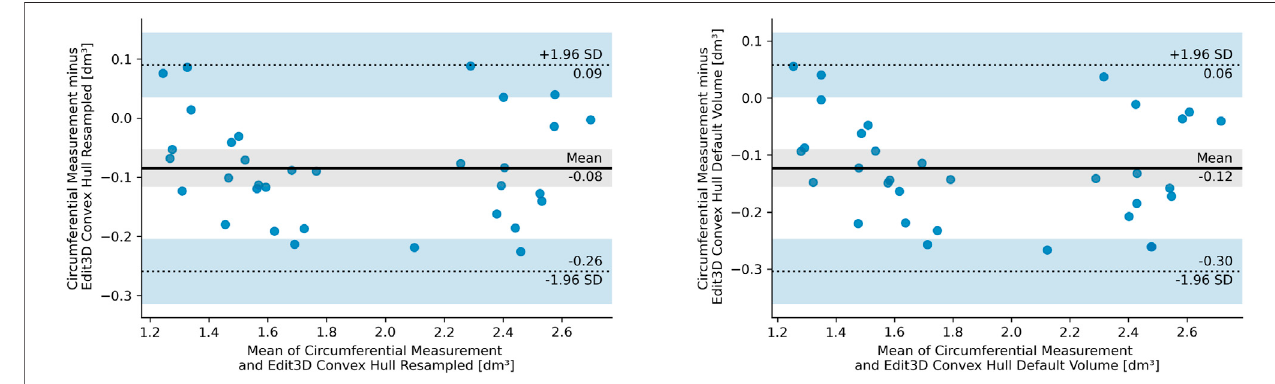
FIGURE5| Bland – AltmanplotofthedifferencesbetweencircumferentialmeasurementsandEdit3Ddefaultconvex-hullvolume(ECHfrommesh,rightpanel),and Edit 3D resampled convex-hull volume (ER CH from point cloud data, left panel). In the pictures, SD stands for standard deviation, dashed lines are the 95% limits of agreement, and blue bands indicate their con fi dence intervals. The gray-shaded areas are con fi dence intervals of the mean difference.